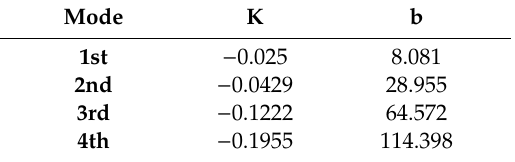
Table 2. Slope coe ffi cients and intercepts for the first four natural